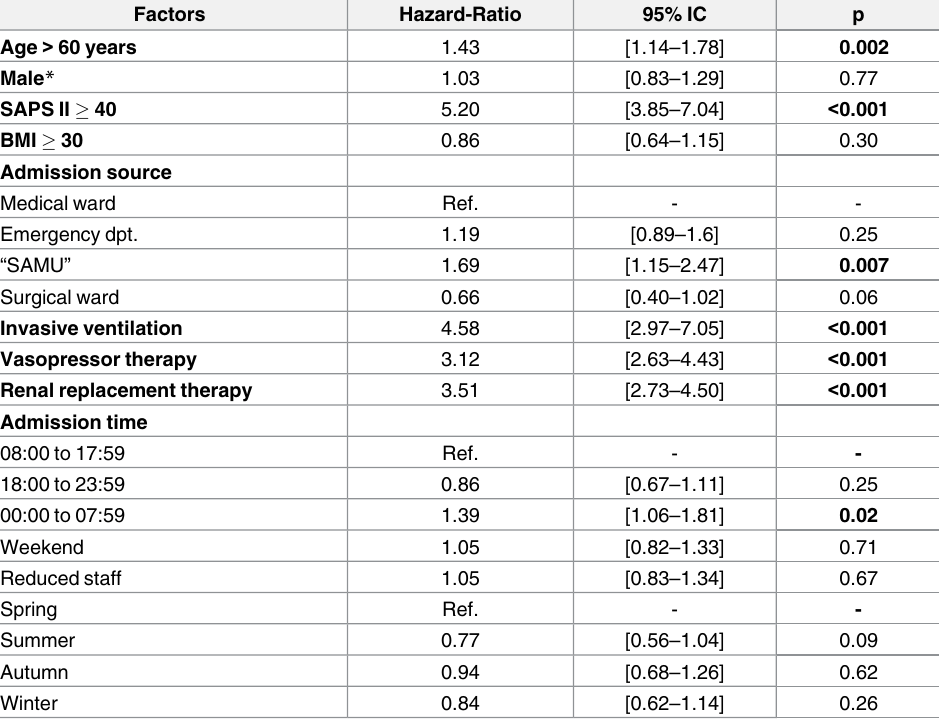
Table 5. Univariate Cox model of factors associatedwith ICU mortality. * As compared with female; Ref: reference category; reducedstaff: weekendand public holydaysadmissions;RRT: renal replacement ther-